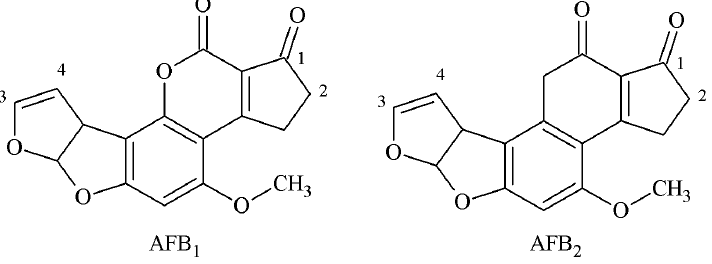
Figure 1. Molecular structure of AFB1 and AFB2.